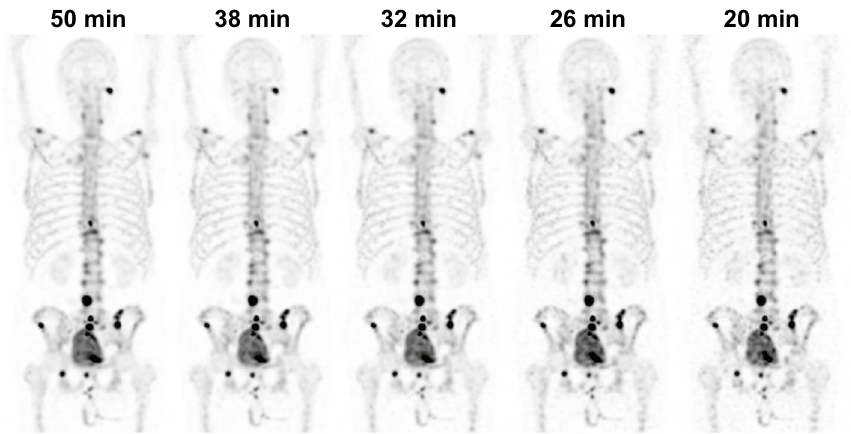
Fig. 1 Whole-body 99m Tc-HMDP SPECT maximum intensity projections of an 80-year-old prostate cancer patient with different acquisition times. The images are filtered using a Gaussian filter with 7-mm FWHM